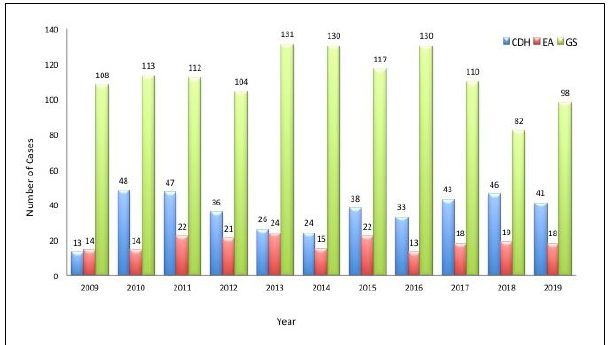
Figure 1. The number of Congenital Diaphragmatic Hernia (CDH), Esophageal Atresia (EA), and Gastroschisis (GS) cases in South Brazil per year, 2009-2019. Table 1. The total number of Congenital Diaphragmatic Hernia (CDH), Esophageal Atresia (EA), and Gastroschisis (GS) cases in South Brazil, 2009-2019 Total